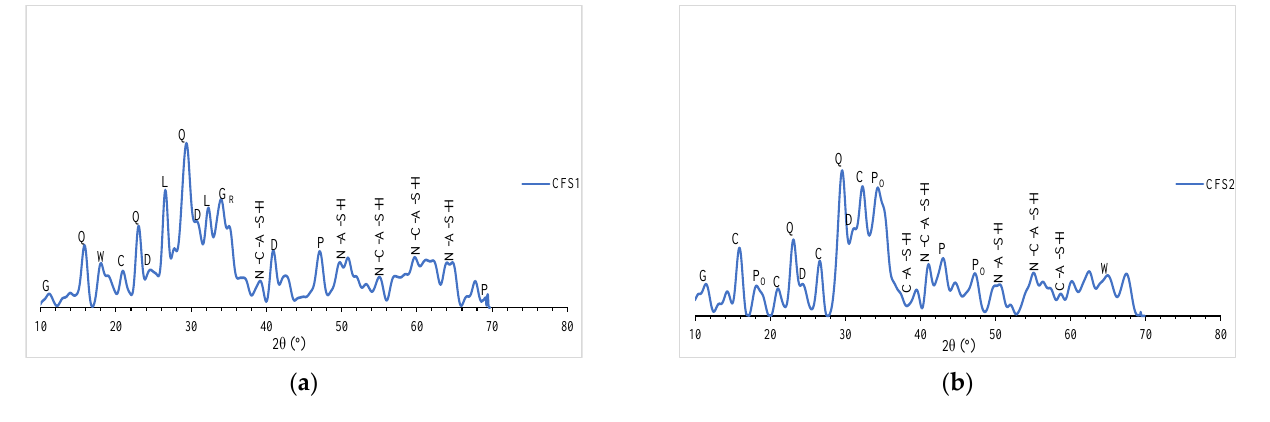
Figure 12. XRD patterns ( a ) CFS4-1; ( b ) CFS-5-2. Table 6. Identified mineral phases in ternary binders.